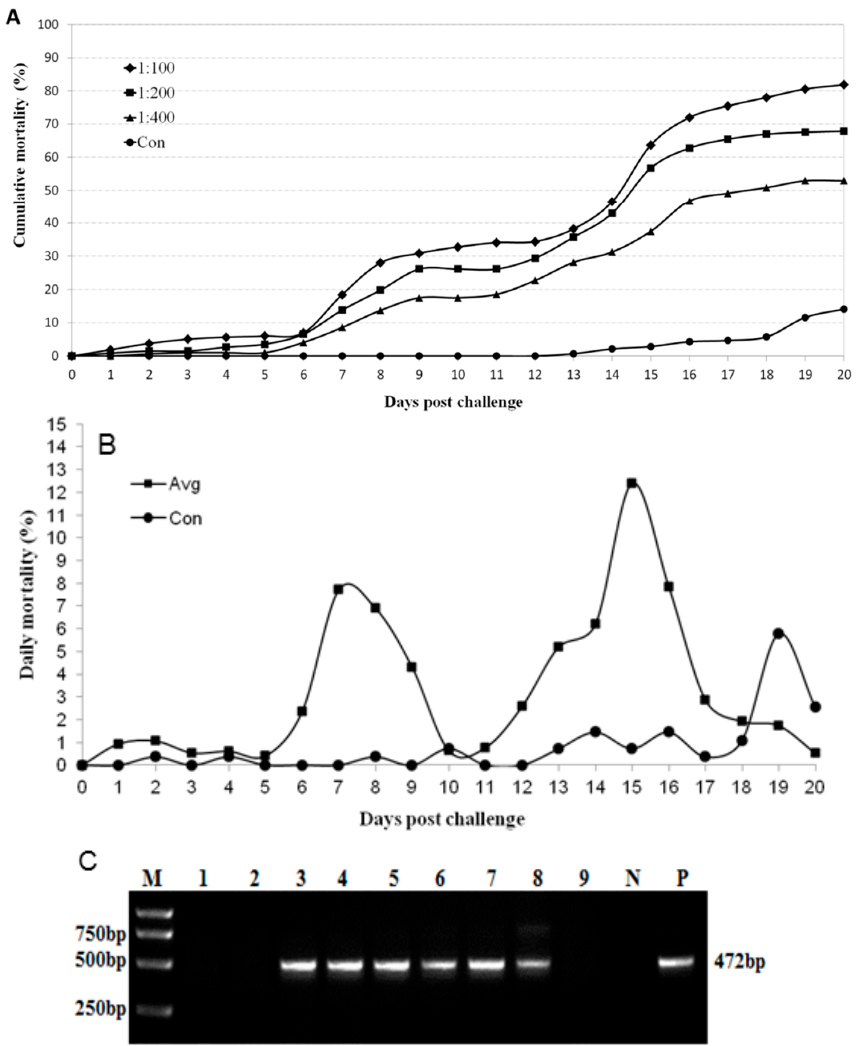
Figure 6. Experimental infection of M. rosenbergii with MrTV. Curves of cumulative mortalities in each group ( A ) or daily mortalities in the three infected groups on average ( B ) were counted at various times during the post-immersion challenge. Three infected groups with different concentration filters (1:100, 1:200, and 1:400) of tissue homogenates were indicated, respectively. The control group was immersed in phosphate-buffered saline ( n = 200). Virus infections from dead larvae in the tested groups (at days 3, 7, and 15) or the control group (at days 0 and 19) were confirmed by RT-PCR ( C ): M, DNA ladder; 1, Chirocephalus ; 2, zero-day in control group; 3–5, seven-day for three infected groups; 6–8, fifteen-day for three infected groups; 9, control group at day 19; N, negative control; P, positive control.